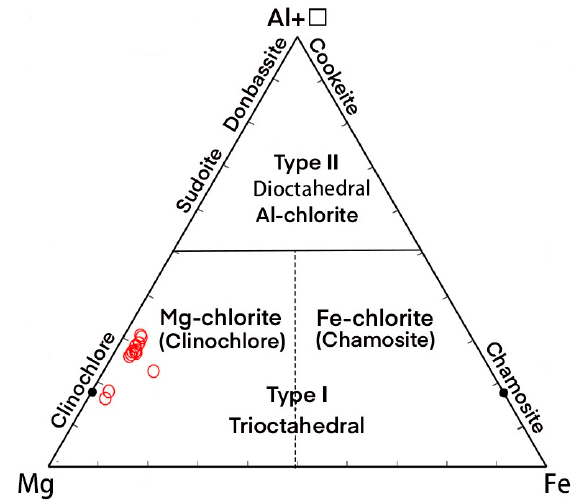
Figure 5. Fe-Mg-(Al+ □ ) classification graph of chlorite in “Laoshan Jade” [29].